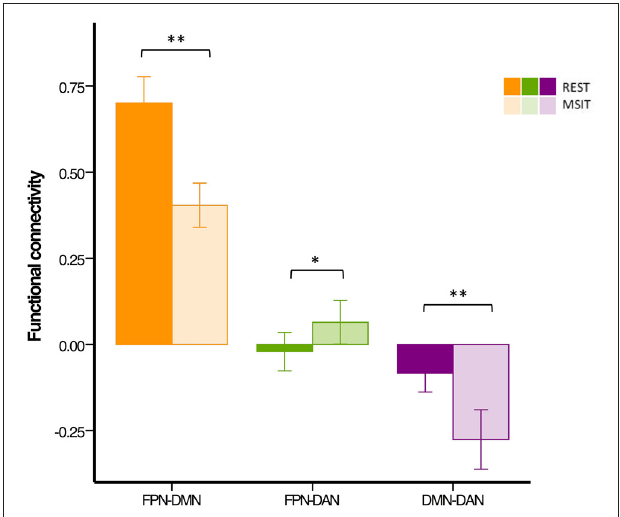
FIGURE 4 | Functional connectivity among the DMN, FPN and DAN during rest and the MSIT for the younger group. Connectivity between the FPN and DMN significantly decreased from rest to task, whereas the opposite trend can be seen for coupling between the FPN and DAN. The DMN and DAN were significantly more anticorrelated during task performance than during rest. ∗ p < 0.05; ∗∗ p <